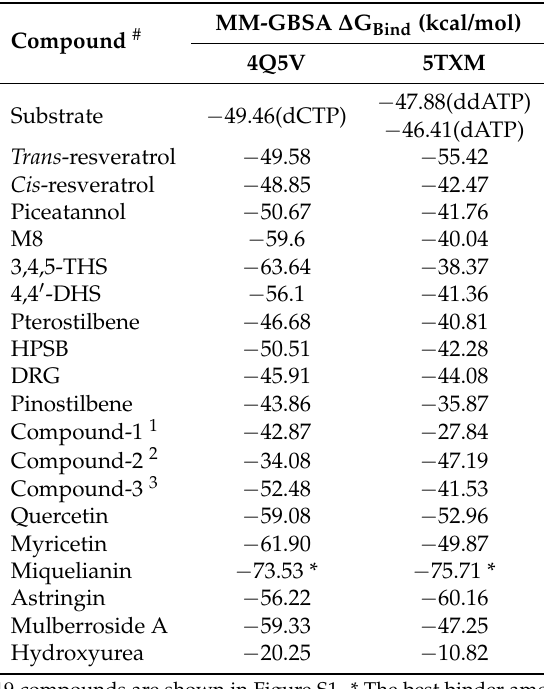
# The structure of the 19 compounds are shown in Figure S1. * The best binder among the 19 compounds. 1 Compound-1: (E)-5-(4-Nitrostyryl)benzo[d][1,3]dioxole. 2 Compound-2: (E)-5-(4-Nitrostyryl)-1,3-phenylene diacetate. 3 Compound-3: